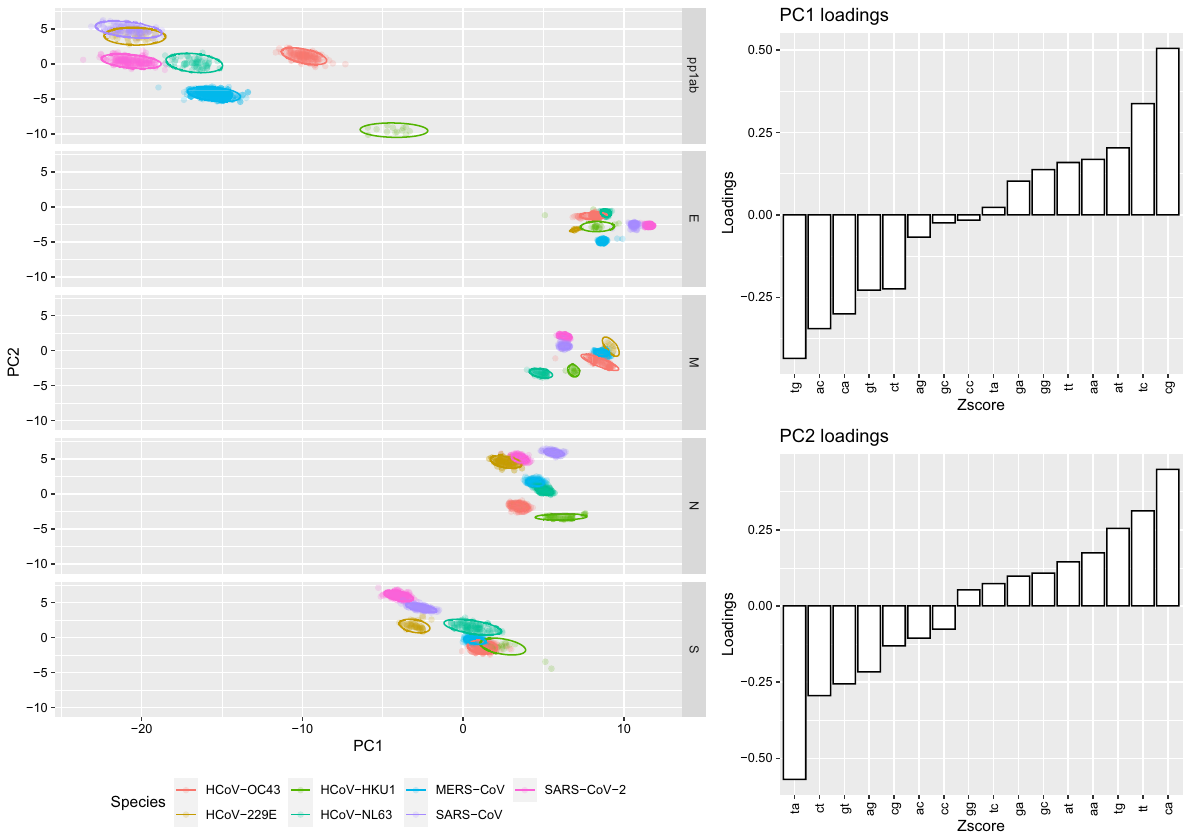
Figure 2. Scatter plot based on the first two components of the PCA performed on Zscore ( a ). The different proteins are reported in separate rows while viral species are color-coded. The PC1 and PC2 loadings are reported in the right